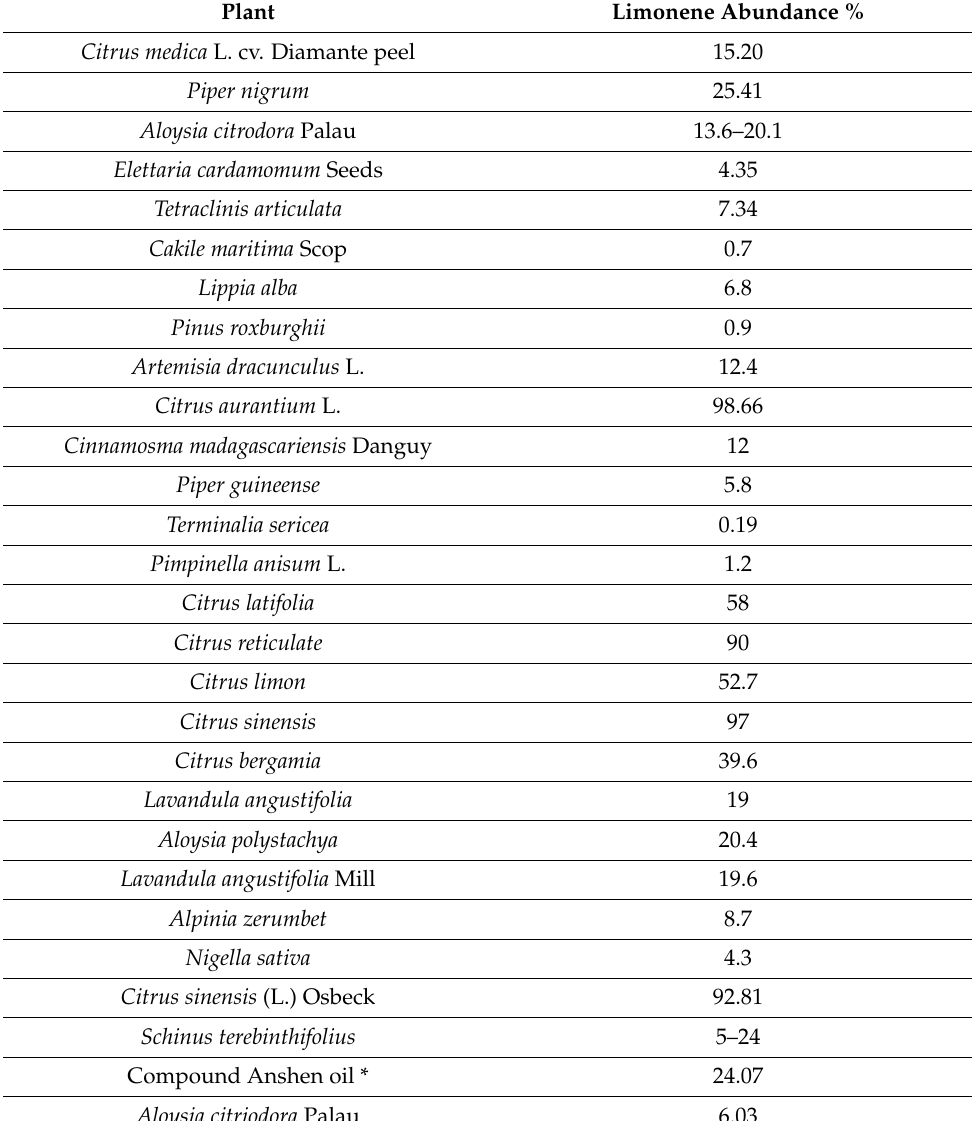
Table 1. Percentage occurrence of limonene in essential